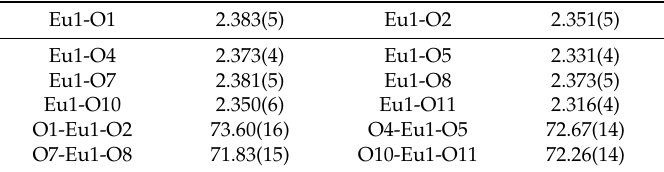
Table 1. Selected bond lengths (Å) and angles ( ◦ ) for the complex 2a .